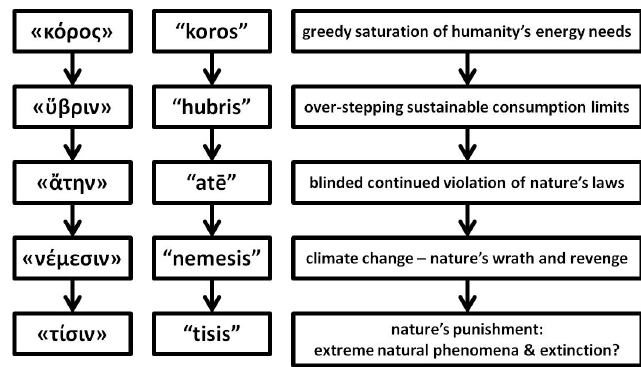
Figure 1. Climate change as a “Greek ‘energy’ tragedy”.